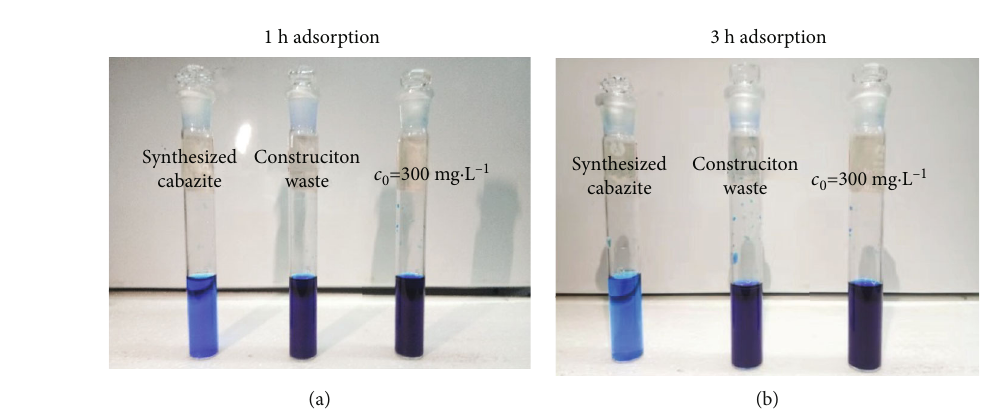
Figure 8: MB solution before and after of the adsorption by construction waste and synthesized